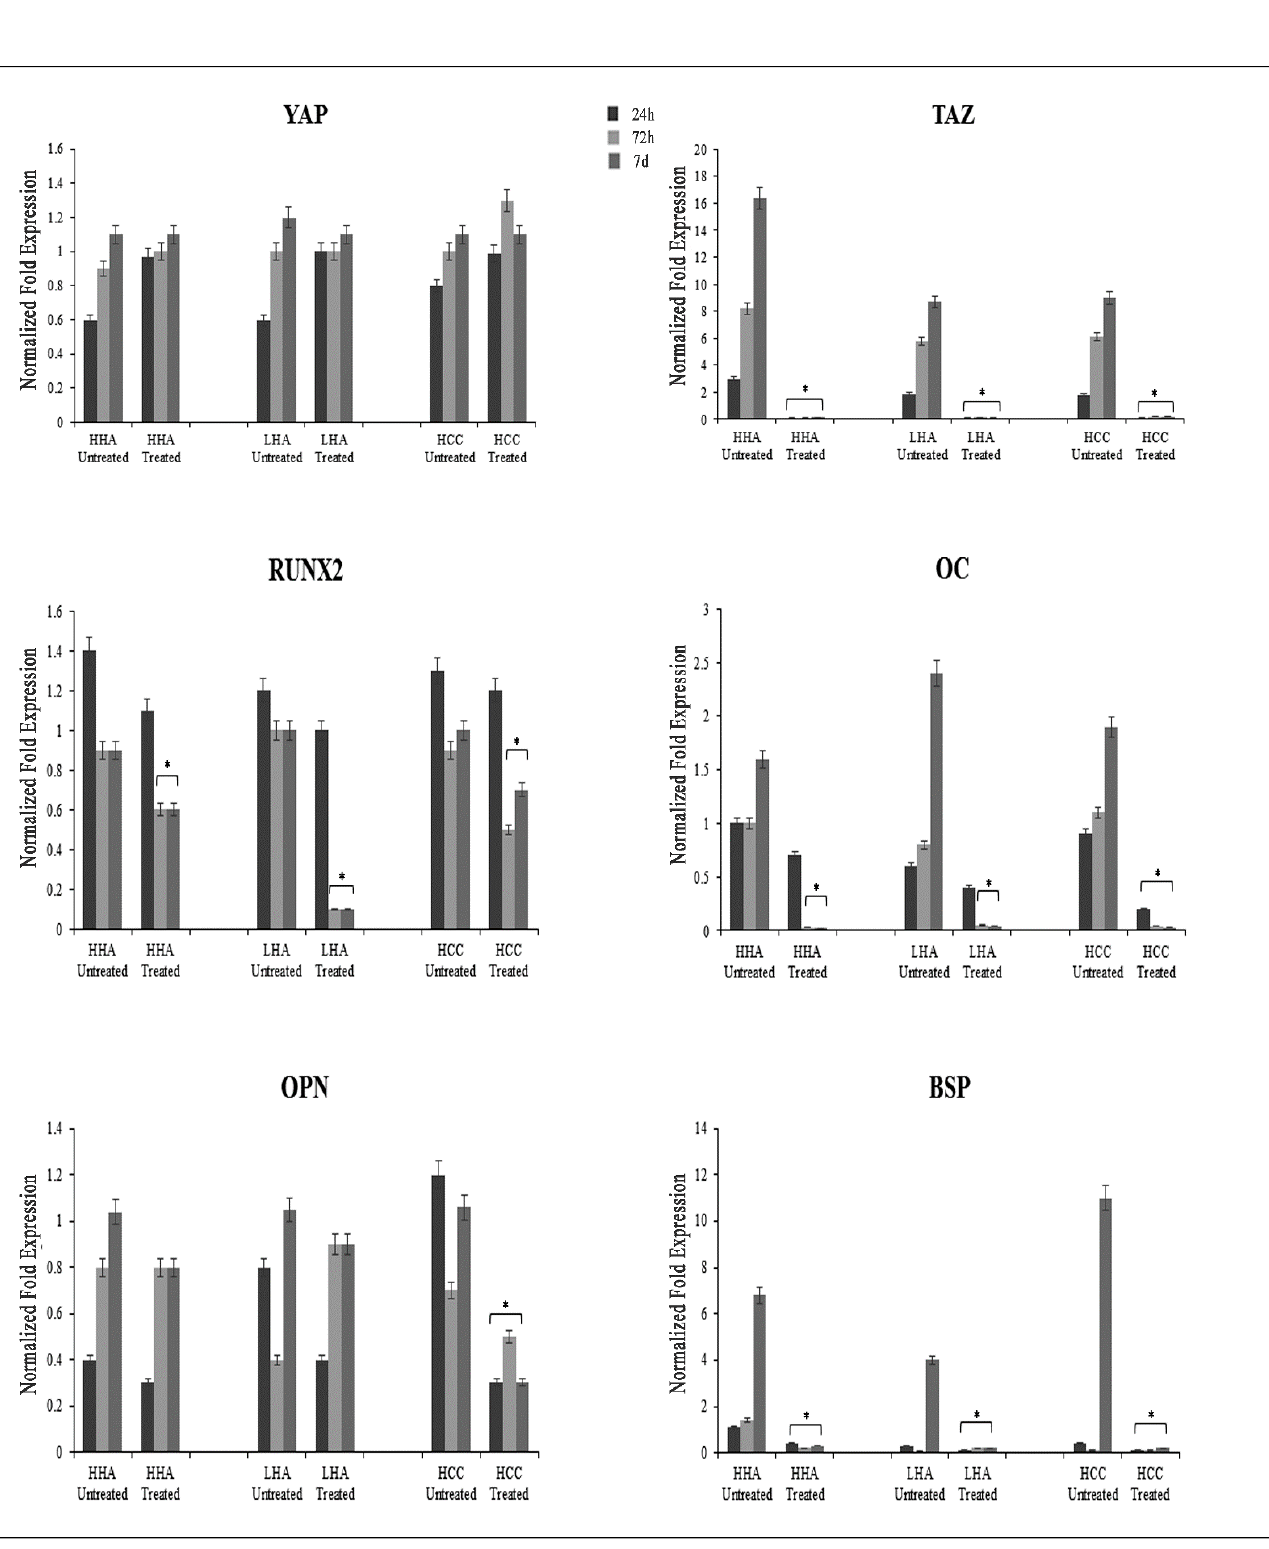
Figure 5. Analysis of YAP , TAZ , RUNX-2 , OC , OPN and BSP gene expression at 24, 72 h and 7 days by qRT-PCR in standard medium after YAP/TAZ inhibitor-1 treatment. The expression of YAP slightly increases after YAP/TAZ inhibitor-1 treatment; TAZ expression is drastically reduced in treated cells; RUNX-2 mRNA levels are strongly downregulated in treated cells, in particular at 72 h and 7 d; all osteogenic related markers, OC , OPN and BSP , are strongly reduced in treated cells. The results are expressed as the mean ± SD of three independent experiments. * p < 0.01 vs. Untreated. Then, we also examined the protein expression of bone related markers, by western blotting. In untreated cells, OC expression was detectable only at 7 days, whereas BSP and